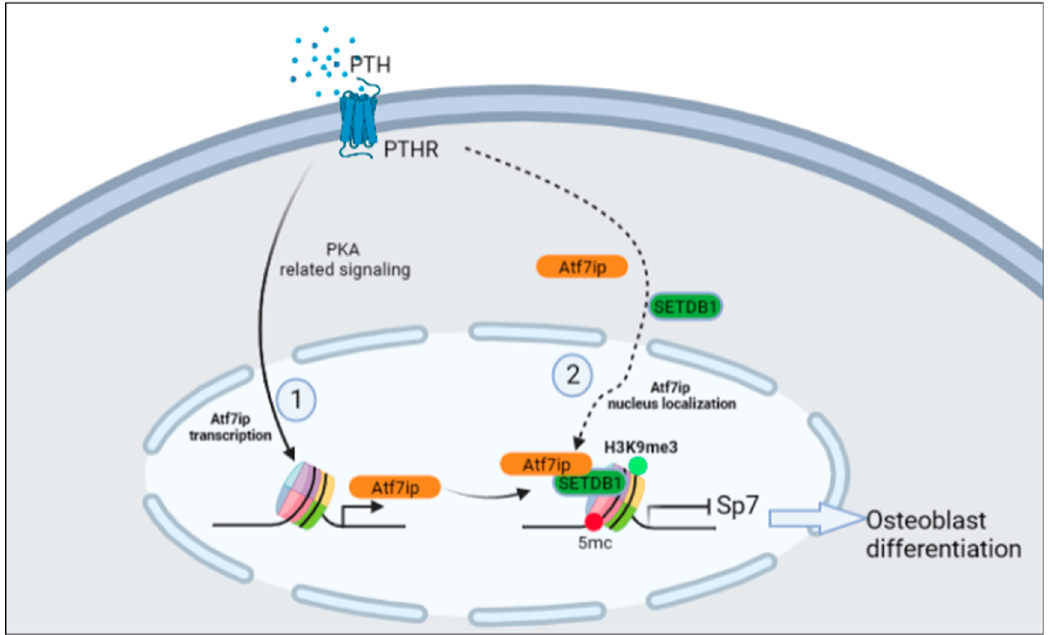
Figure 7. The figure abstractly reviews the mechanisms underlying the negative regulatory effect of Atf7ip on osteoblast differentiation. Atf7ip is upregulated by PTH–PKA ‐ related signaling in MC3T3 ‐ E1 cells and regulated the nuclear localization of Setdb1, which further inhibited Runx2 activity and Sp7 expression, thereby inhibiting osteoblast differentiation.